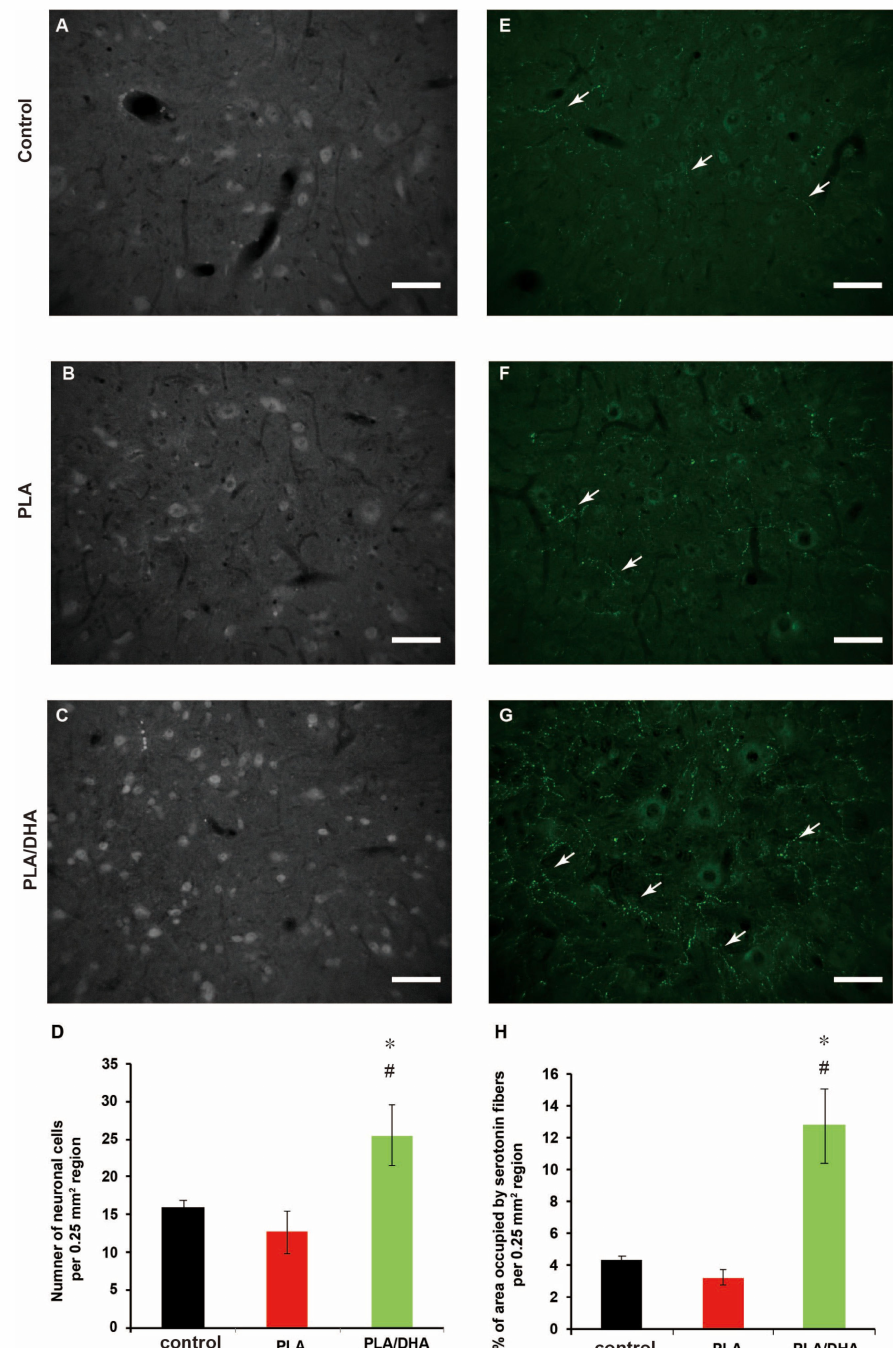
Figure 10. The polylactic acid / docosahexaenoic acid (PLA / DHA) core-shell nanofiber membrane (CSNM) prevented neuronal nuclei (NeuN) immunopositive cell loss and increase serotonin (5-HT) positive neurofiber sprouting in the rat after spinal cord injury. ( A–C ) The sections caudal to the injury site of the contused rat spinal cord were immunostained for NeuN and analyzed (bar = 100 µ m). ( D ) The PLA / DHA CSNM implanted rats show significantly increased NeuN immunolabelled cells when compared to control and PLA groups at 21 days post-injury. ( E–G ) The sections show serotonergic fibers (white arrows) in the spinal cord tissue caudal to the lesion site after staining with anti-serotonin antibody (bar = 100 µ m). ( H ) The quantification of serotonergic fibers reveals the serotonergic fiber is significantly increased in rats receiving PLA / DHA CSNM implantation. * p < 0.05 compared with control, # p < 0.05 compared with